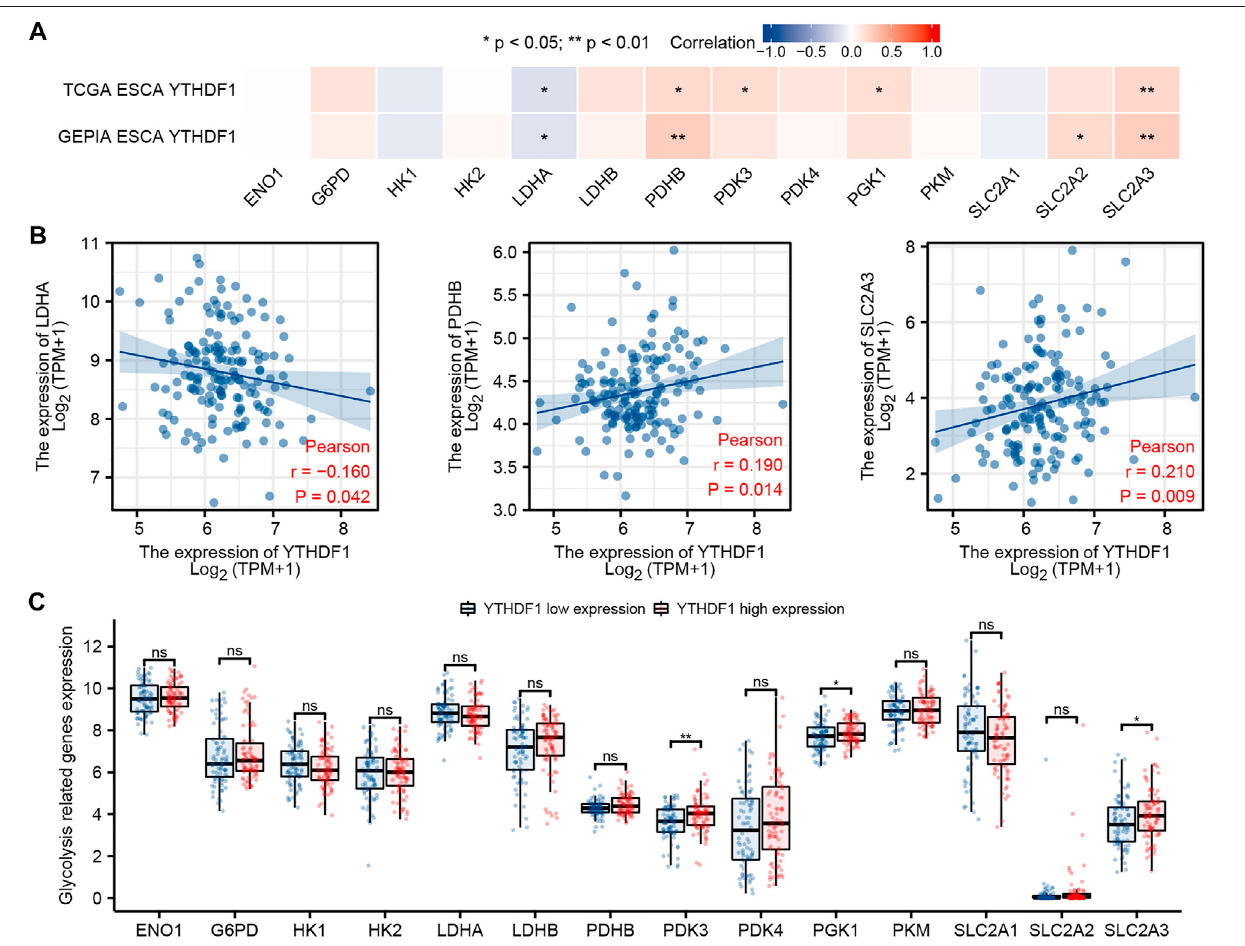
FIGURE 7 | Correlation between YTHDF1 expression and glycolysis-related genes in esophageal carcinoma (ESCA). (A) Correlation between expression of YTHDF1and14glycolysis-relatedgenesinTCGAand GEPIAESCAcohorts. (B) ScatterplotdemonstratethecorrelationbetweenYTHDF1andthreeglycolysis-related genes (PDHB, SLC2A3, and LDHA) in TCGA ESCA cohort. (C) Differential expression of 14 glycolysis-related genes between the high and low expression groups of YTHDF1 in ESCA. * p < 0.05; ** p < 0.01; *** p < 0.001; ns, no signi fi cance.